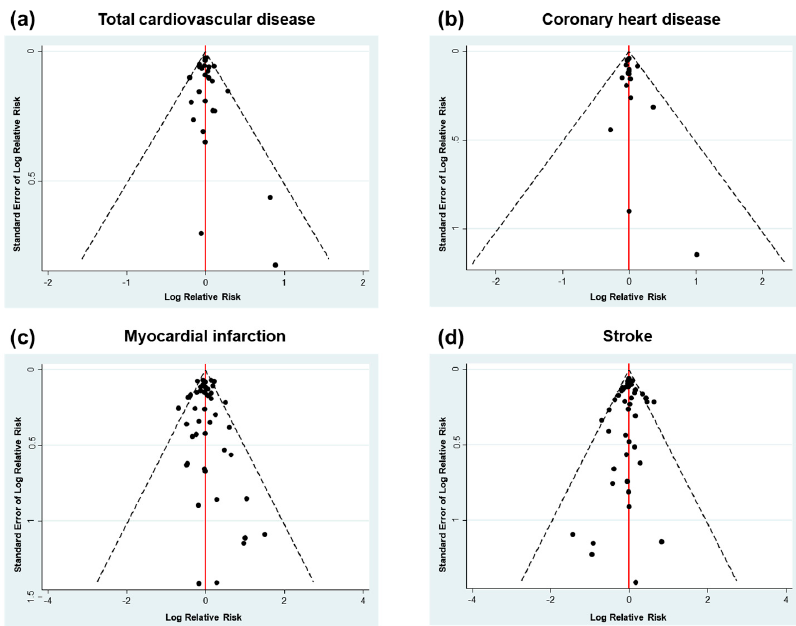
Figure 3. Funnel plot for publication bias according to (a) total cardiovascular disease, (b) coronary heart disease, (c) myocardial infarction, and (d) stroke.